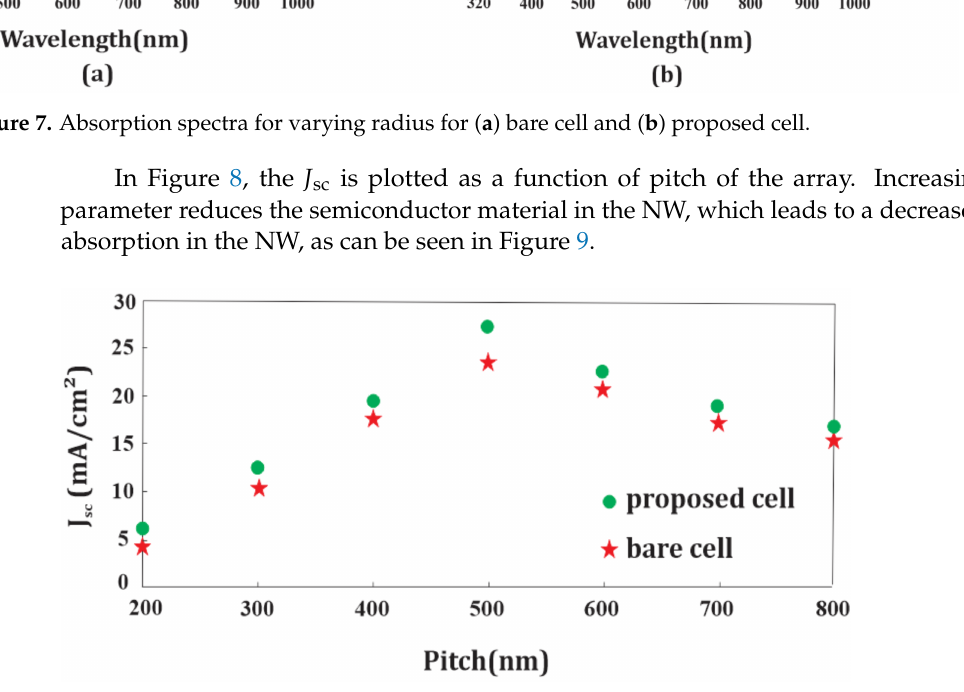
Figure 8. The short circuit current density (in mA/cm 2 ) of the bare cell and proposed cell of InP NW array solar cell for varying